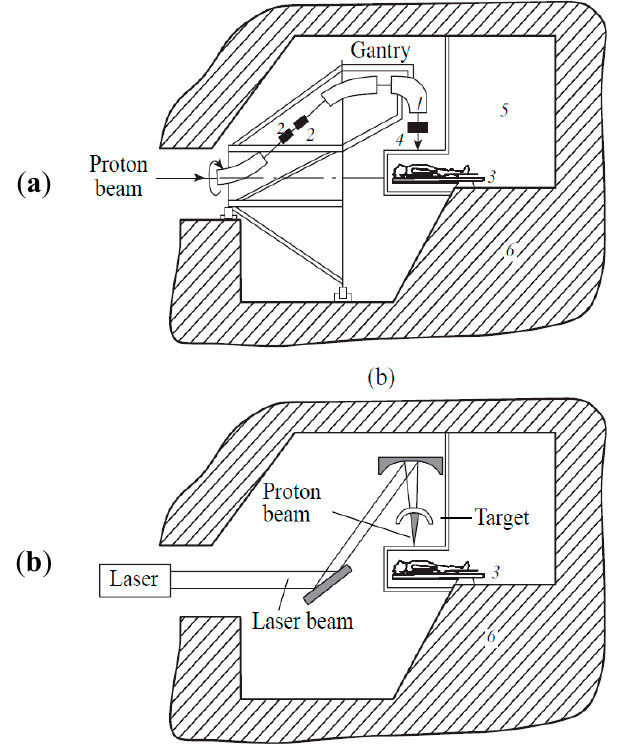
Figure 14. ( a ) Conventional gantry system to direct the ion beam to the patient. This can normally be about 100 tons in weight and very expensive; ( b ) The design of an optical (laser) gantry system which uses mirrors to convey the beam closer to the patient. Reproduced from [68]. Copyright 2002, MAIK “Nauka/Interperiodica”.